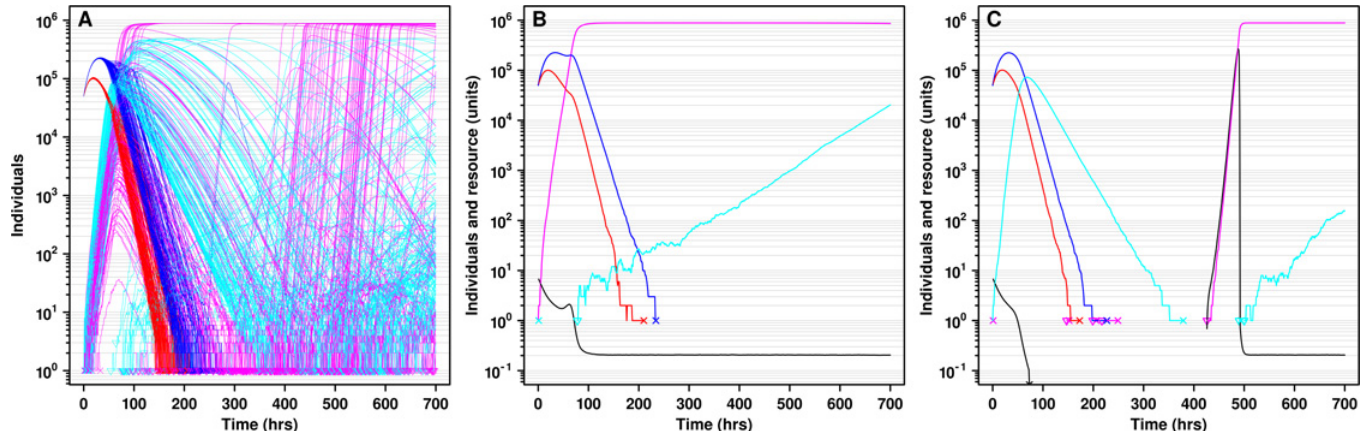
Fig 8. Under defector-induced resource limitation, mutant dynamics dominate metapopulation dynamics. A ) An example metapopulation initialized with 100% of its locations occupied. Each population initially contained 1 C * and 1 D * . Each curve shows the population size of C (red), D (blue), C * (magenta), or D * (cyan) in one location of a metapopulation. In most locations, D * drove both C * and itself extinct. B ) In some locations, C * initially outlived D * by chance. C * then rose to high frequency and outcompeted both C and D . New D * were generated by mutation of C * . C ) C * individuals from populations depicted in B could migrate into other locations that were emptied due to extinction induced by D *